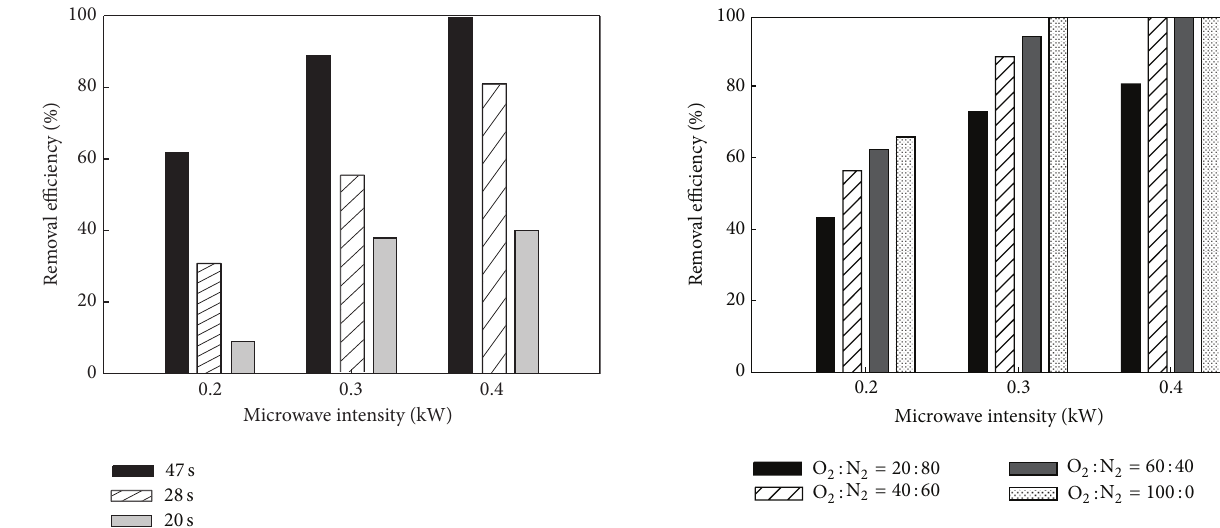
Figure 7: Effect of carrier gas composition on degradation of